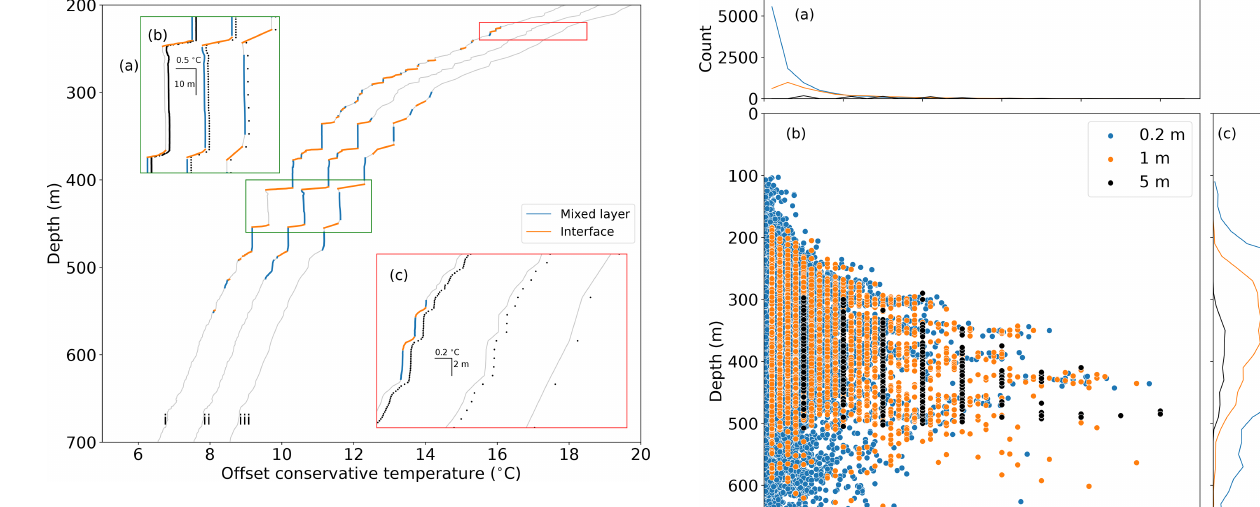
Figure 12. SG620 dive 20 fast-response thermistor temperature. Three profiles are the same data binned at 0.2, 1 and 5m respec- tively and then classified. Panels (b) and (c) are detailed subsamples of the profiles; offset black dots mark the centres of each depth bin. Glider data from the tropical North Atlantic.